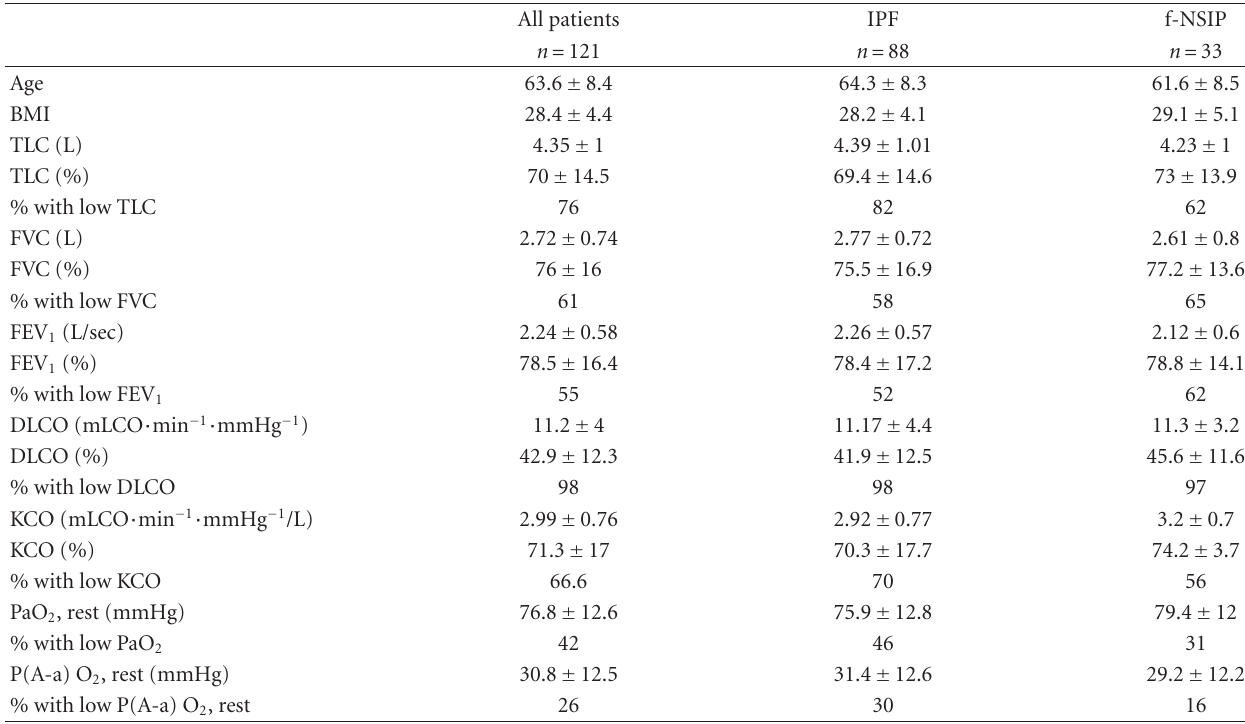
Table 1: Pulmonary function tests results.